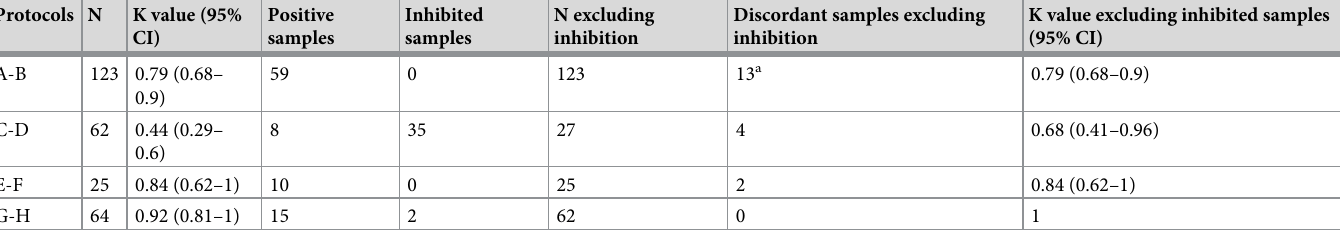
Table 7. Cohen’s kappa coefficient (K) results for the comparison between protocols with the Real-Time PCR procedure as the only variable. K values are shown including and excluding inhibited